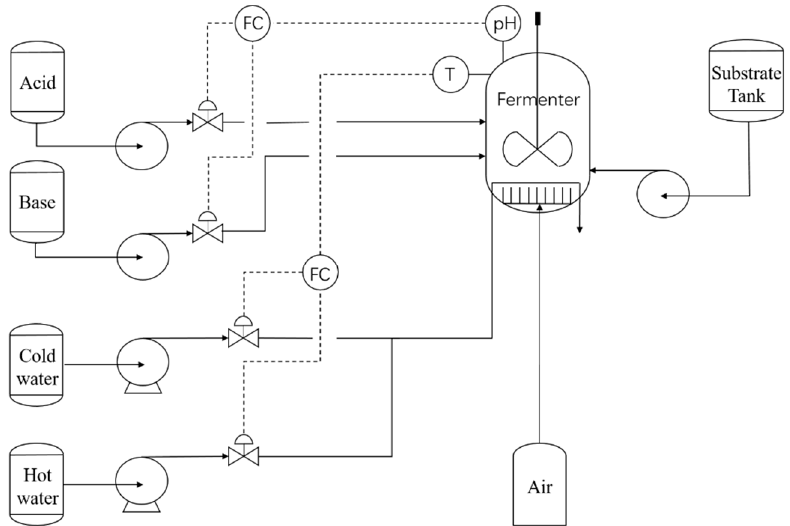
Figure 4. The process of penicillin fermentation.